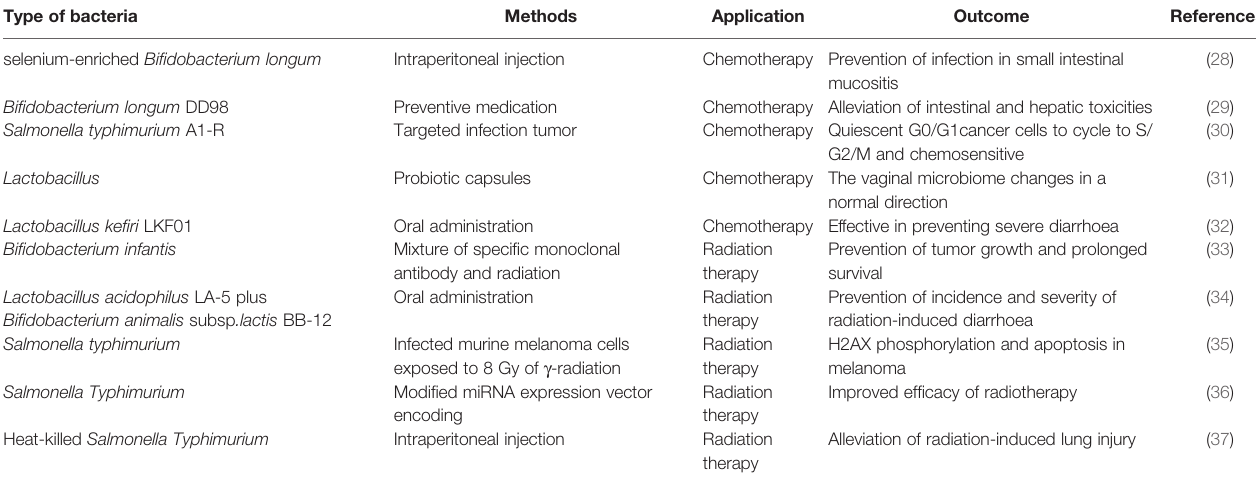
TABLE 1 | Summaries of studies on bacteria with chemotherapy and radiation therapy. Type of